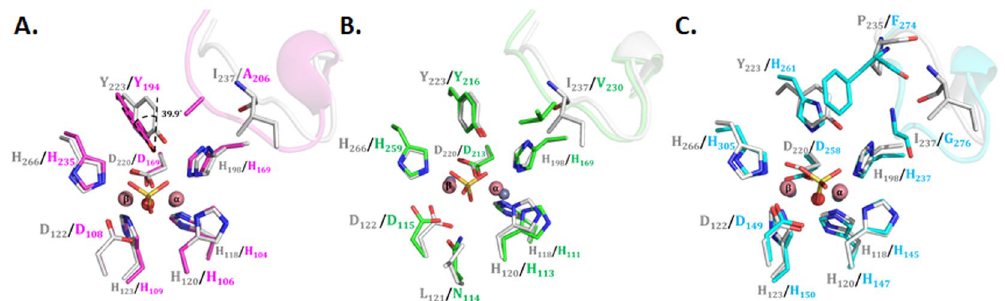
Figure 6. Comparison of AaL active site with AiiA, AiiB, and AidC. ( A ) Superposition of AaL (in grey sticks) and AiiA (in pink sticks) highlights a reorientation of Y223/Y194 and of the active site loop (237-loop in AaL). ( B ) Superposition of AaL (grey sticks) and AiiB (green sticks) reveals a different metal coordination geometry (AaL cations are shown as pink spheres, AiiB cations as grey spheres) and the substitution I237/V230. ( C ) Superposition of AaL (grey sticks) and AidC (cyan sticks) active sites. Active site residues occupies similar configurations, with the exception of the Y223/H261 substitution, and residues on loops (P235/F274 and I237/ G276). The phosphate-bound structure of AaL was used in these figures. Metal cations (pink spheres for AaL, grey spheres for other enzymes) and the bridging water molecule are shown as well as the bound anions shown as sticks.